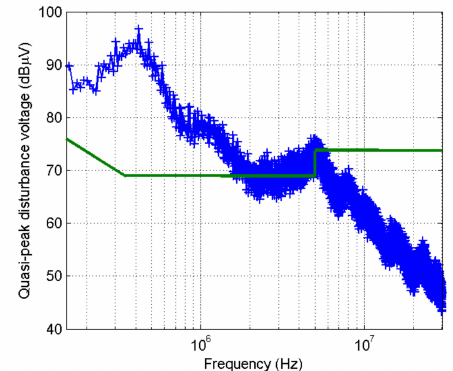
Figure 6. Testing for the conducted EMI. Measurement results for the motor loaded with the rated torque, no PWM modulation, at a speed of n = 10,000 rpm. Speed controlled by adjustment of the RMS value of the AC voltage feeding the drive. No input EMC filter. Green line denotes the standard imposed levels. Additional load torque and increasing rotational speed does not change the high frequency